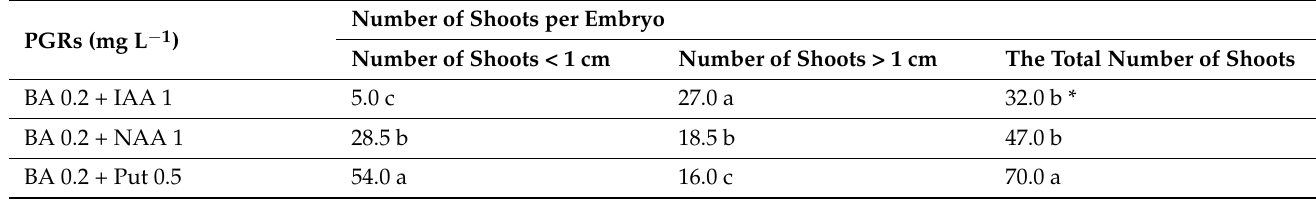
Table 5. Effect of PGRs on shoot multiplication of “Czerwona Kula”. Basal MS medium containing 30 g L − 1 sucrose was used for shoot